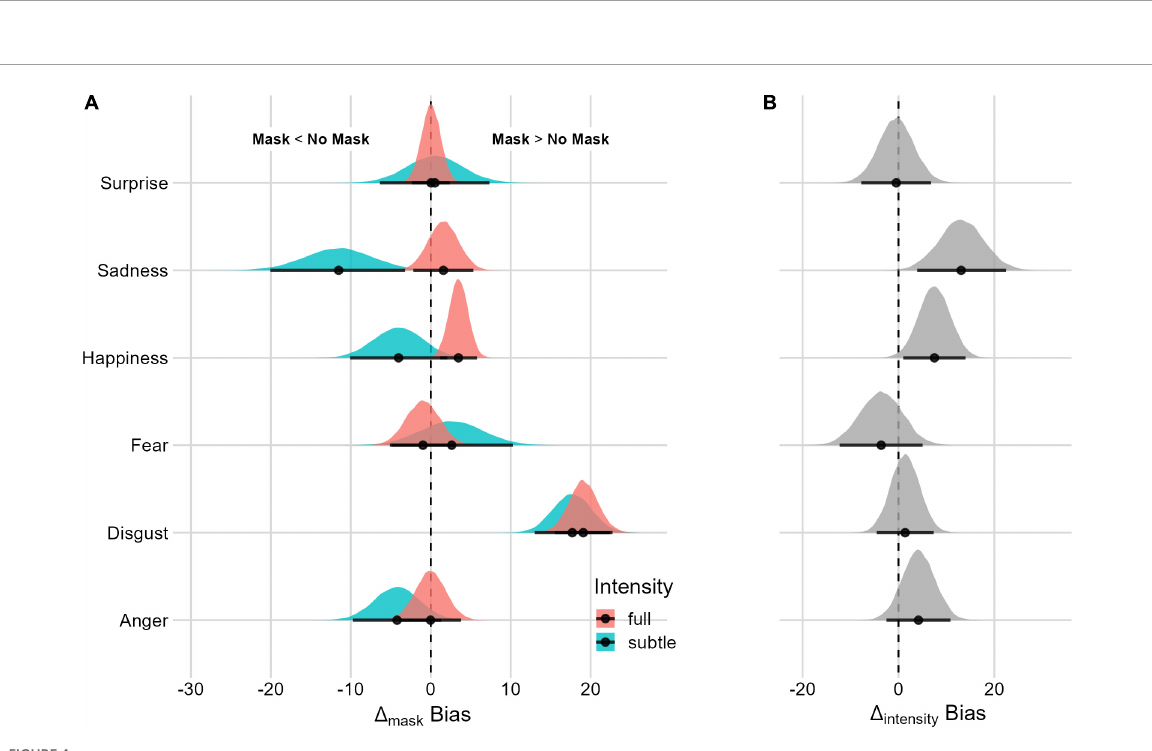
FIGURE4 Posterior distributions and 95% HPDIs of the bias Facial Expression Intensity Effect. (A) Posterior distributions of Mask (cid:49) as a function of the Facial Expression Intensity condition. (B) Posterior distribution of the Facial Expression Intensity (cid:49) contrast (Mask (cid:49) full –Mask (cid:49) subtle